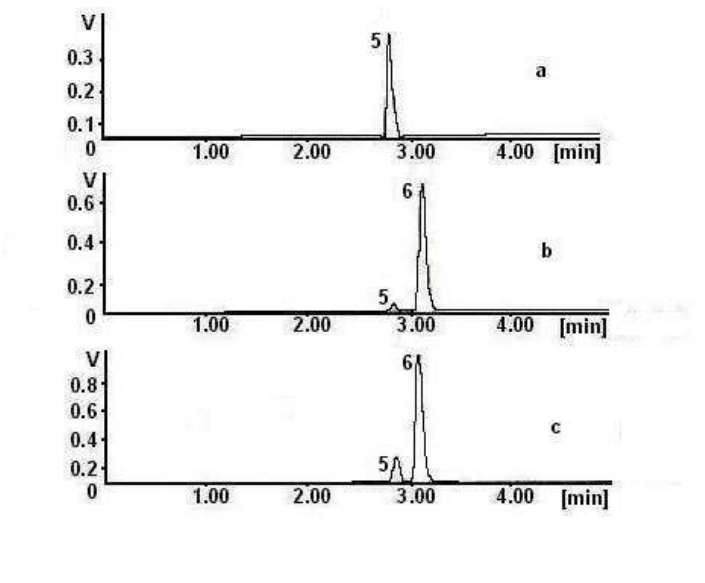
Fig. 1 HPLC monitoring (212 nm) of crude 2-bromobenzyl bromide ( 6 ): a) chromatogram of 2-bromotoluene ( 5 ) (Merck); b) chromatogram of 2-bromobenzyl bromide ( 6 ) (Merck); c) chromatogram of crude 2-bromobenzyl bromide ( 6 ) [impurified by ( 5